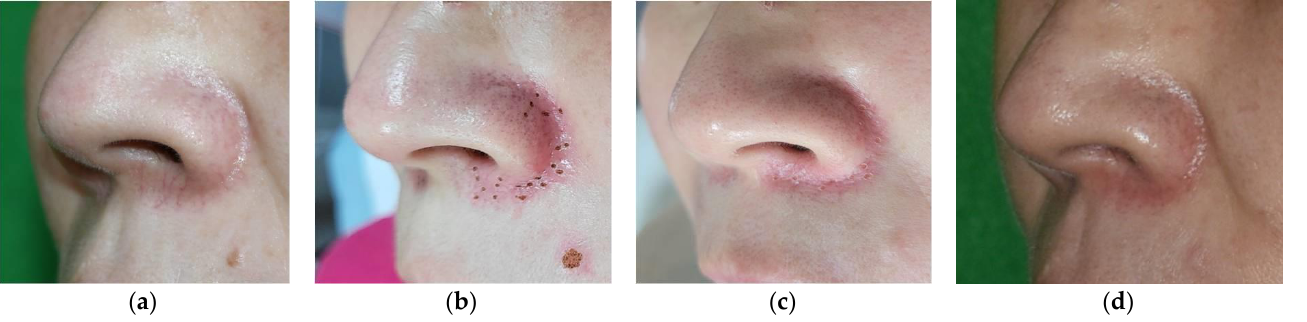
Figure 4. Facial telangiectasia in a 45-year-old man. ( a ) Telangiectasia on the nasal alar area before treatment. ( b ) Multiple deep holes were made in line with the course of the telangiectasia. ( c ) The telangiectasia showed significant improvement 1 month after the first treatment session with the pinhole method using the CO 2 laser. However, a slight amount of hyperpigmentation was noted. ( d ) Hyperpigmentation was slightly improved at 6-month follow-up.